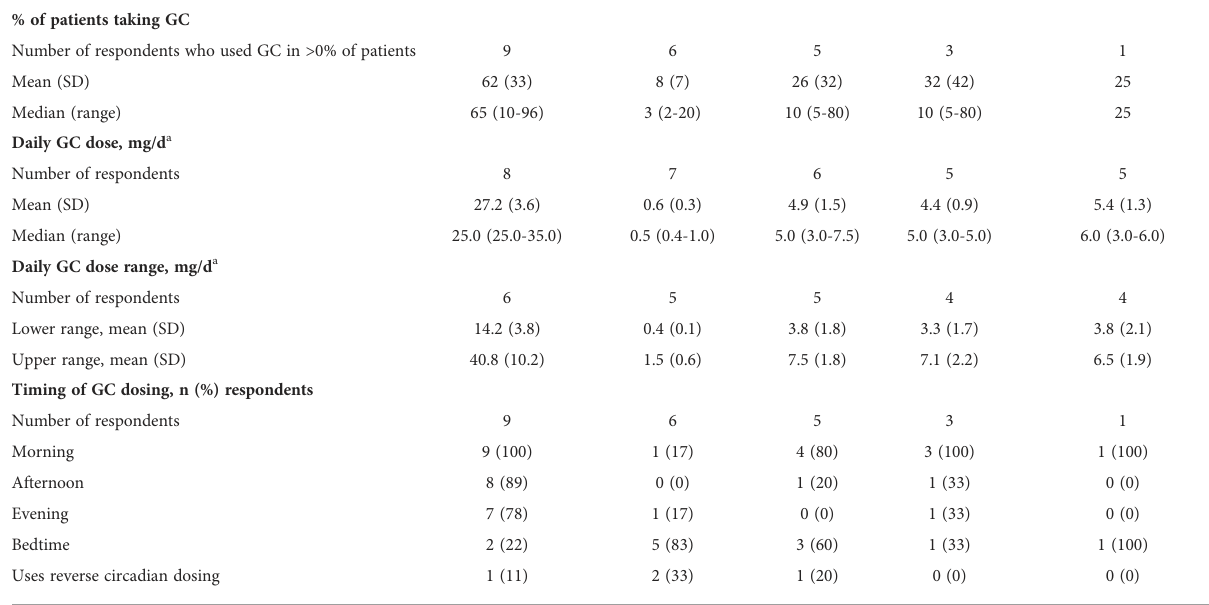
TABLE 1 Glucocorticoid treatment patterns in adults with classic